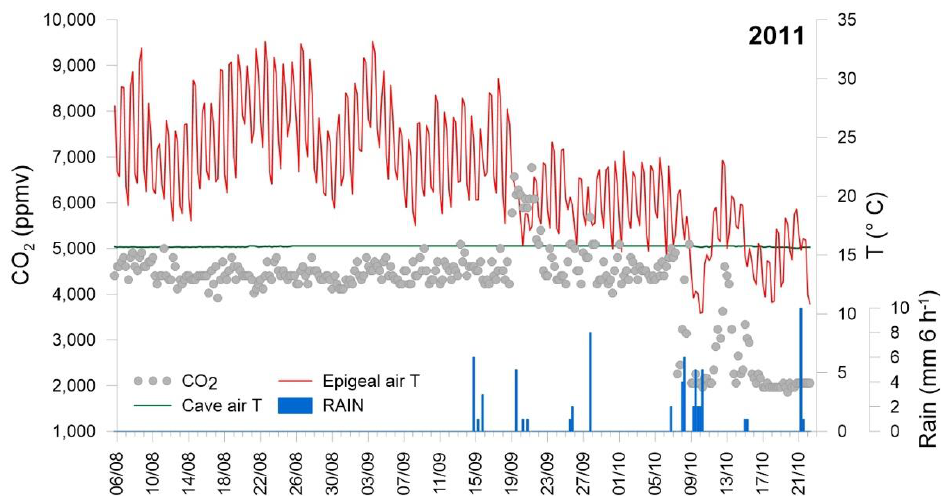
Figure 10. Near-real-time data of air temperature (hourly, green line) and CO 2 concentrations (grey points, 1 acquisition every 6 h) acquired inside Santa Ninfa cave between August and October 2011; daily average epigeal air temperatures (red line) and rainfall amount (vertical blue bars, every 6 h) are reported for comparison.